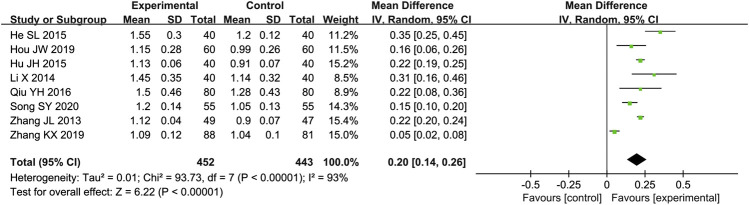
Forest plot of E/A.